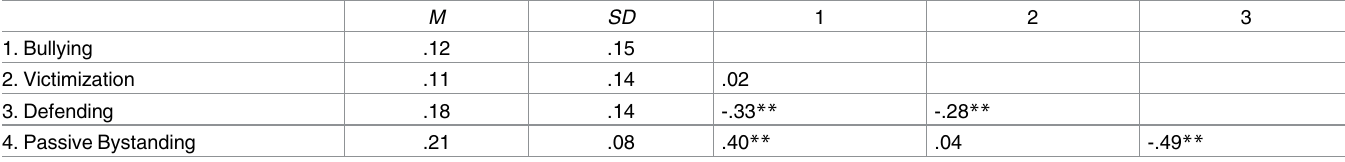
Table 5. Means, standard deviations, and correlations between behaviors during bullying episodes scores.